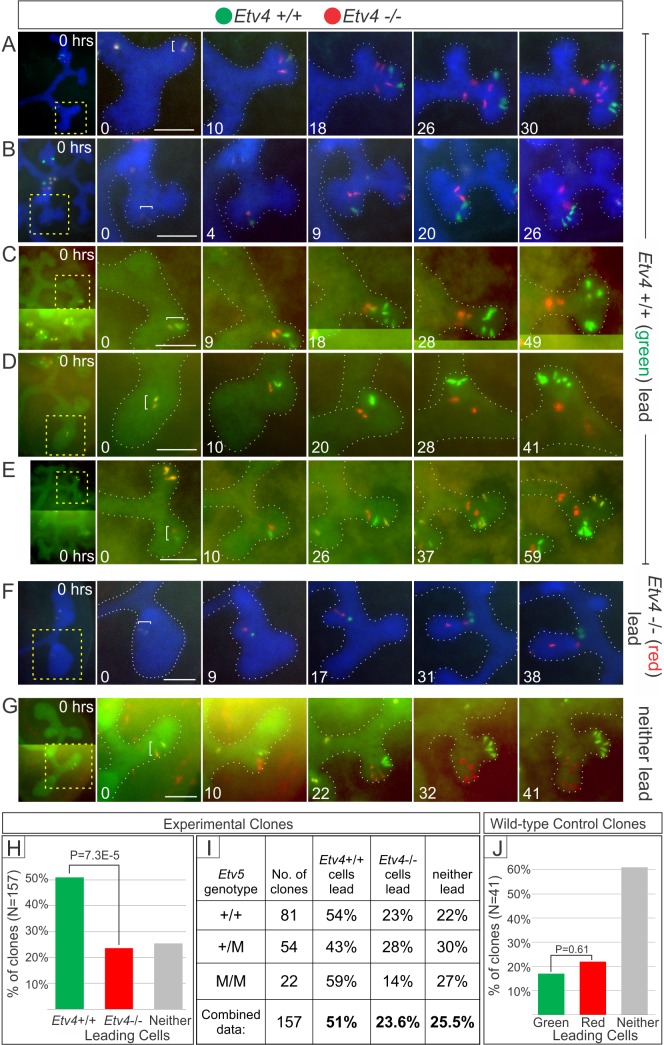
Time-lapse analysis of Etv4-MADM clones in cultured kidneys.Forty-four E11.5−E12.5 kidneys, in which rare MADM recombination was induced by Hoxb7/Cre [46], were cultured and imaged every 30 or 60 min. In all cases, green cells were Etv4+/+ and red cells were Etv4−/−; yellow clones were Etv4+/−, like the starting kidney. A–G show the development of seven Etv4-MADM clones. A–E, five clones in which Etv4+/+ cells ended closer to the UB tip(s) than their Etv4−/− sisters. F, one clone in which Etv4−/− cells ended closer to the tip than the Etv4+/+ cells. G, one clone in which Etv4+/+ and Etv4−/− cells were equally close to two UB tips. The kidneys in A–C and G were Etv5+/+, those in D and F were Etv5+/M, and the kidney in E was Etv5-M/M. The kidneys also carried R26R-CFP [47], expressed throughout the UB (after recombination by Hoxb7/Cre), and visible in the blue channel (A, B, F) or by spillover to the green channel (C–E, G). H, percentage of Etv4-MADM clones (including all Etv5 genotypes) in which Etv4+/+ cells ended closer to the UB tips, or Etv4−/− cells ended closer to the tips, or neither was clearly closer. I, comparison of the Etv4-MADM results in kidneys of different Etv5 genotypes. J, analysis of MADM clones in control kidneys, in which both red and green cells were wild type for Etv4. Scale bars, 100 μm. Time-lapse sequences are shown in S4 Movie. Data for Fig 4H–4J available from the Dryad Digital Repository: http://dx.doi.org/10.5061/dryad.pk16b [42].